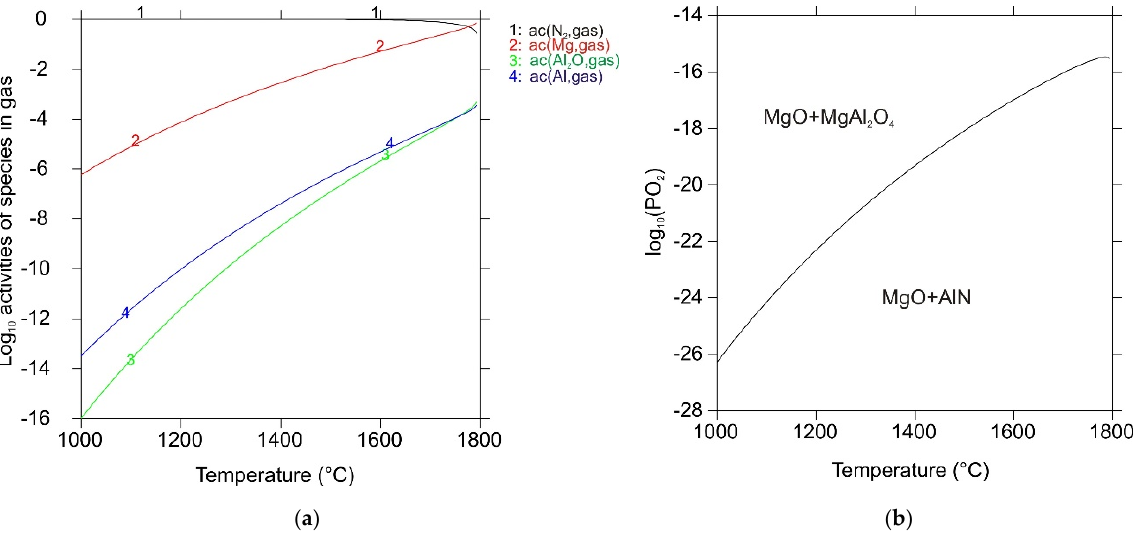
Figure 2. Equilibrium of MgAl 2 O 4 with Al 2 O 3 and AlN in the presence of gas as a function of tem- perature: ( a ) activities of gas species and ( b ) partial pressure of oxygen (in bar); the dashed line shows the stability limit of MgAl 2 O 4 .